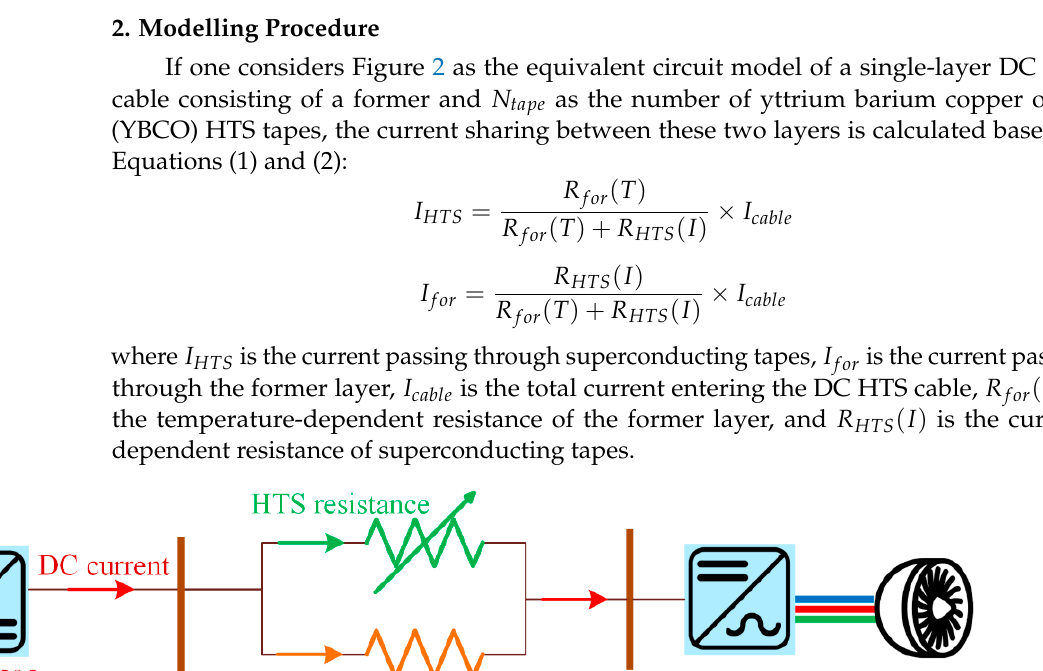
Figure 1. The structure of HTS devices in a cryo-electric aircraft, cooled down to cryogenic temperatures.